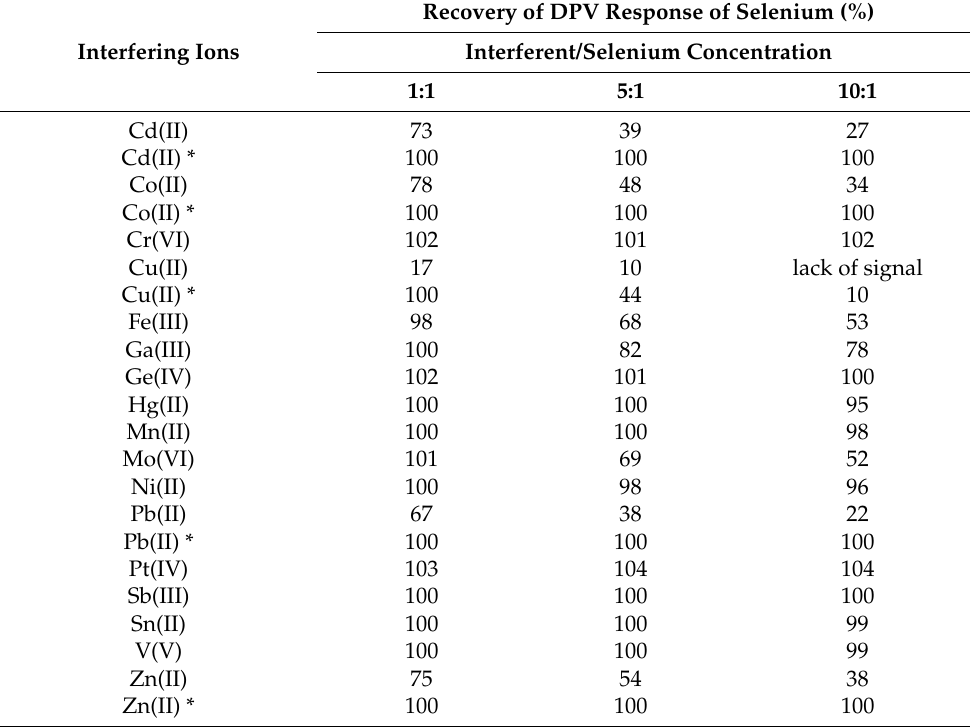
Table 2. The effect of interfering ions on DPV response of selenium at BiFE. Recovery as a ratio of selenium signal in the presence of interfering ions to the signal obtained in the absence of these ions upon rounding to the whole number (expressed as a